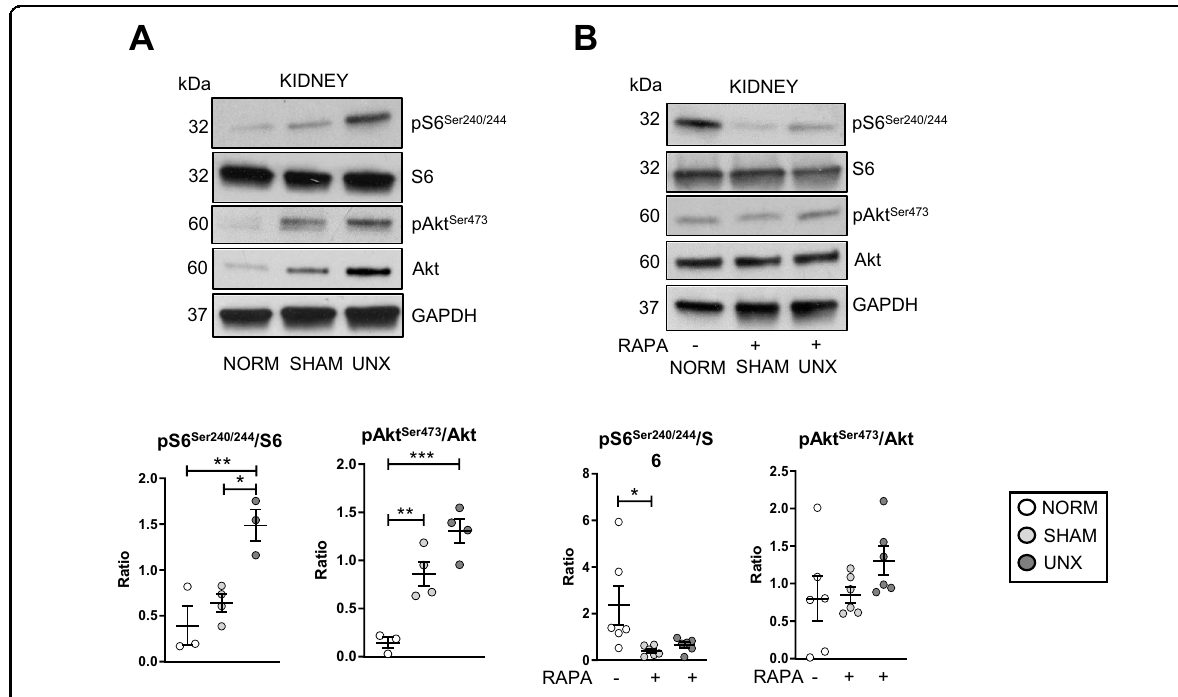
Fig. 1 Increased mTORC1 (pS6Ser240/244) after UNX and mTORC2 (pAktSer473) after sham surgery and UNX in the kidney is attenuated by rapamycin. Mice underwent either no surgical manipulations (NORM), sham surgery (SHAM), or unilateral nephrectomy (UNX) and after 2 h the contralateral kidney was harvested. A Representative immunoblots and relative densitometry is shown for mTORC1 (pS6 Ser240/244 ) and mTORC2 (pAkt Ser473 ) substrates in the kidney. * P < 0.05, ** P < 0.01, *** P < 0.001. RDU = relative densitometry units corrected for GAPDH. B Representative immunoblots and relative densitometry is shown for mTORC1 (pS6) and mTORC2 (pAkt Ser473 ) substrates in the kidney after treatment of mice with rapamycin (RAPA). * P < 0.05, ** P < 0.01. RDU = relative densitometry